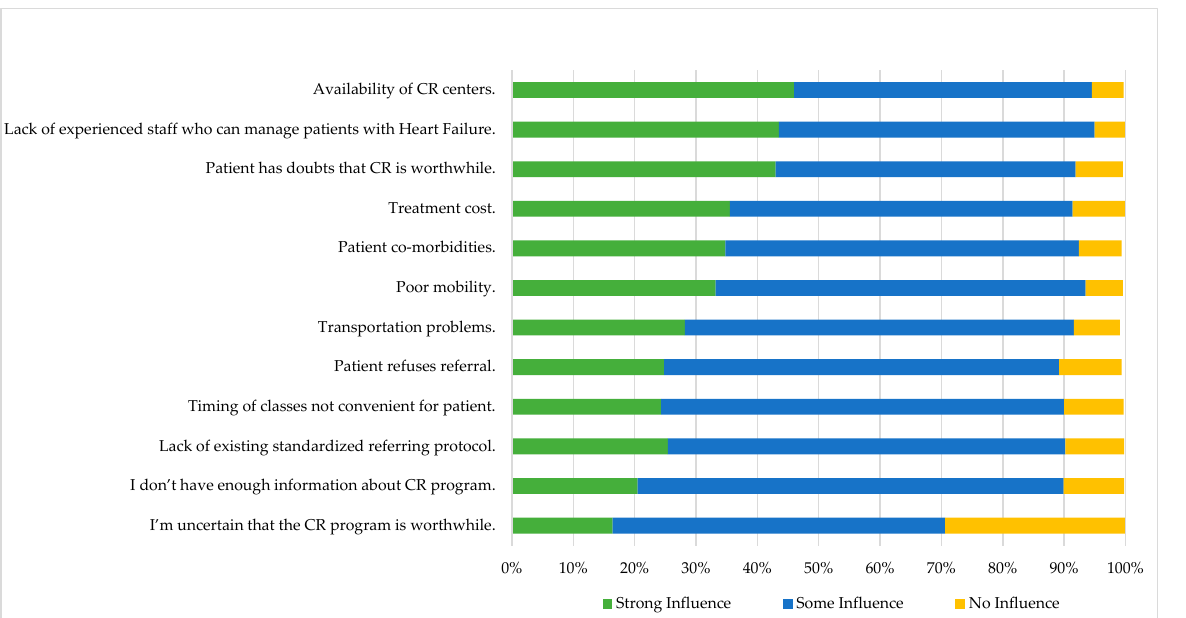
From the nurses’ perspective, the main barriers that strongly affect the referral pro- cess of patients with HF for CR included the availability of CR centers (46%), followed by the lack of experienced staff who can manage patients with HF (43.50%) and the patients’ doubts about whether or not CR is worthwhile (43%) (Figure 2).